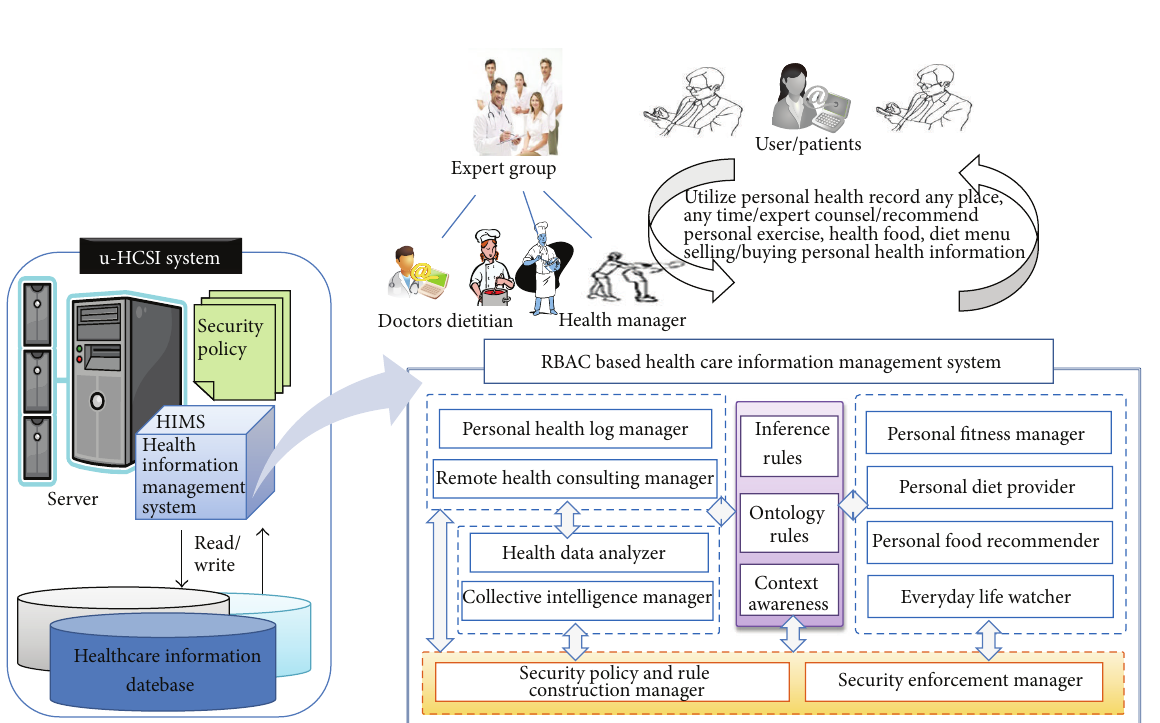
Figure 12: Search drug information.